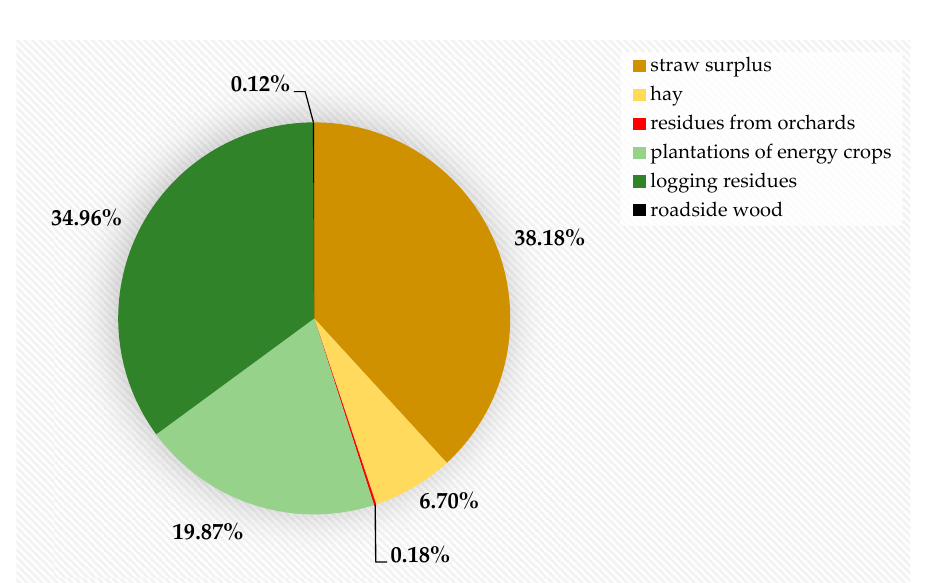
Figure 2. The proportion of individual solid biomass resources in the total energy potential of the commune of Goworowo (%).